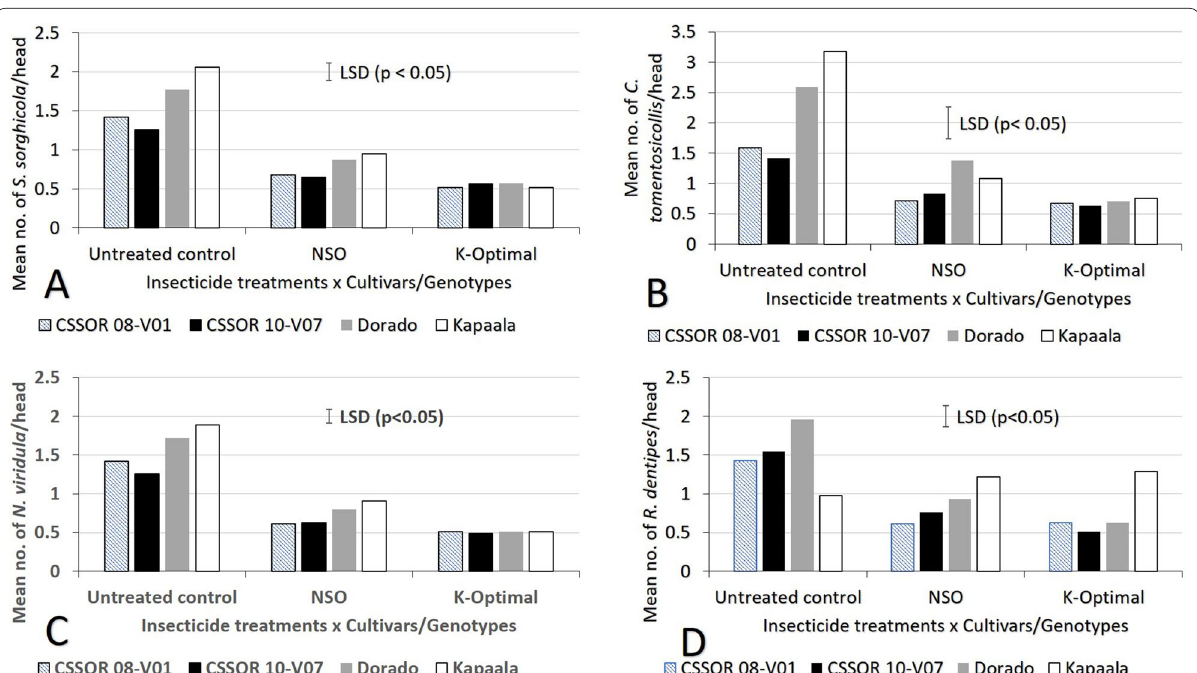
Fig. 2 Insecticide treatments Cultivars/Genotypes interaction effect on the mean number of A Stenodiplosis sorghicola, B Clavigralla × tomentosicollis, C Nezara viridula and D Riptortus dentipes in the 2017 cropping season. Note: NSO difference at 5% probability